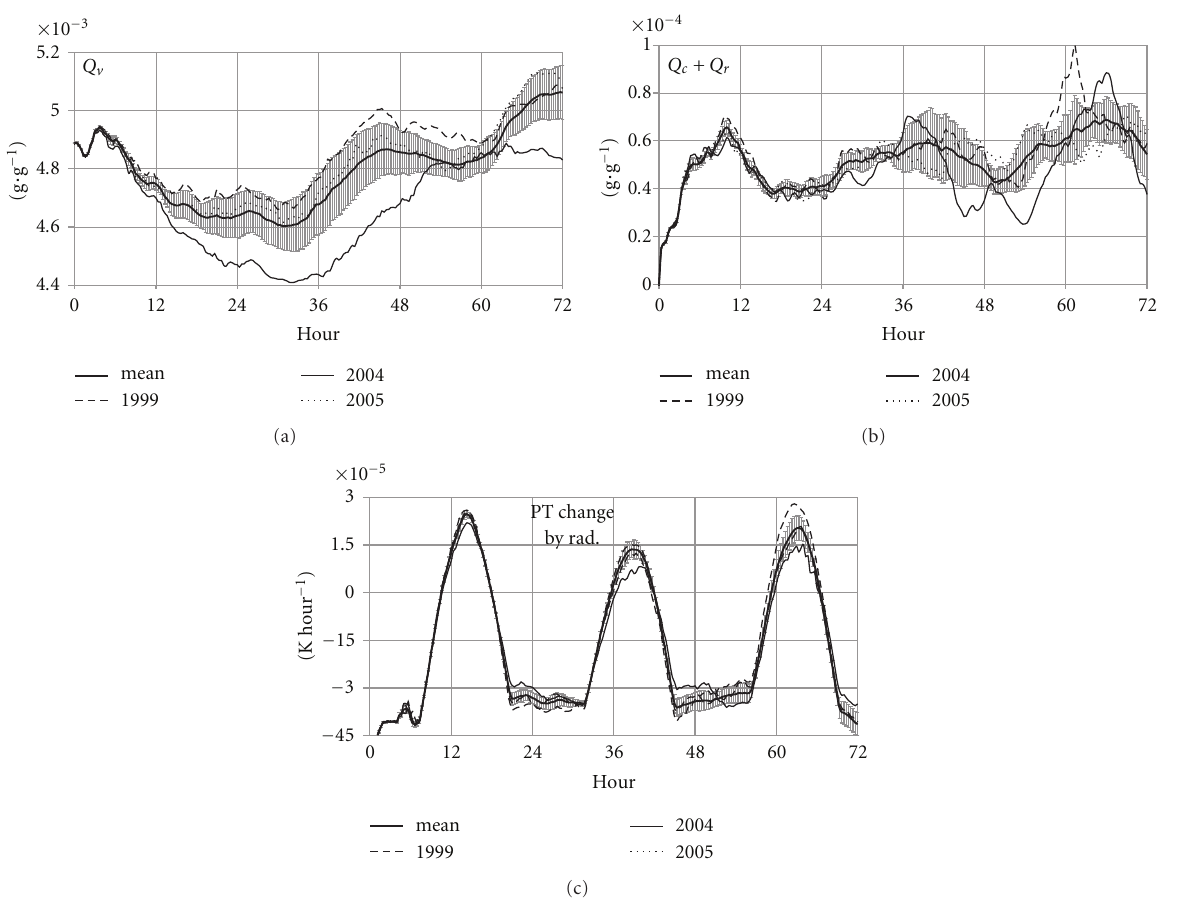
Figure 15: (a) Time series of mean specific humidity ( Q v , g · g − 1 ) averaged over the nine NCM predictions within a radius of 300 km from the predicted Hai-Tang’s center, along with time series of specific humidity in 1999, 2004, and 2005 predicted by NCM, also averaged within a radius of 300 km from the predicted Hai-Tang’s center: (b) same as Figure 15(a) except for mean specific cloud ( Q c ) plus specific rain ( Q r , g · g − 1 ); and (c) same as Figure 15(a) except for mean hourly change in potential temperature caused by radiation (K per hour).